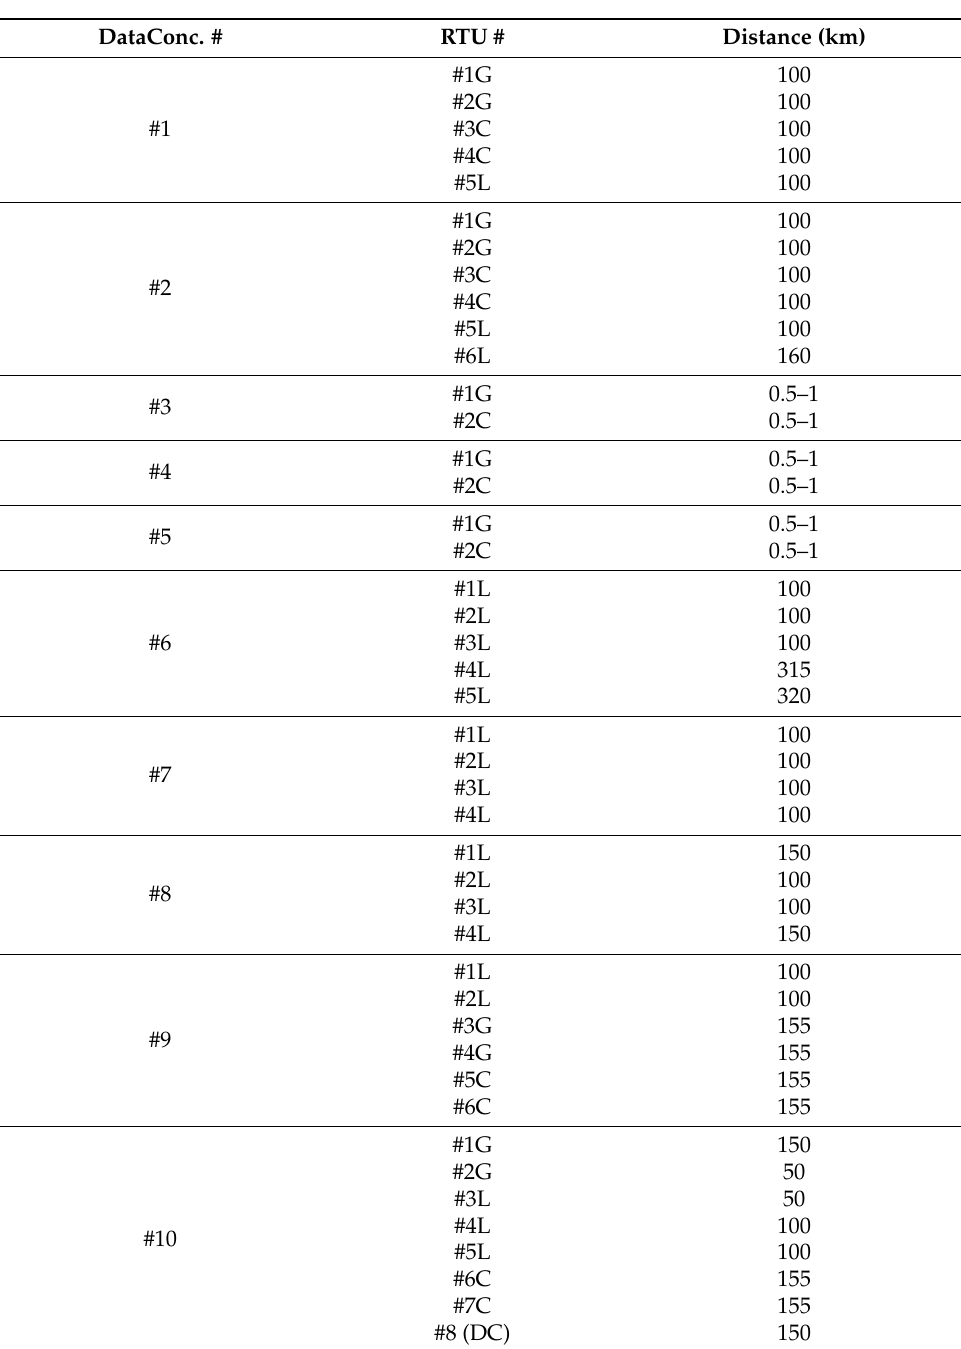
Table A1. RTUs (cid:29) Data